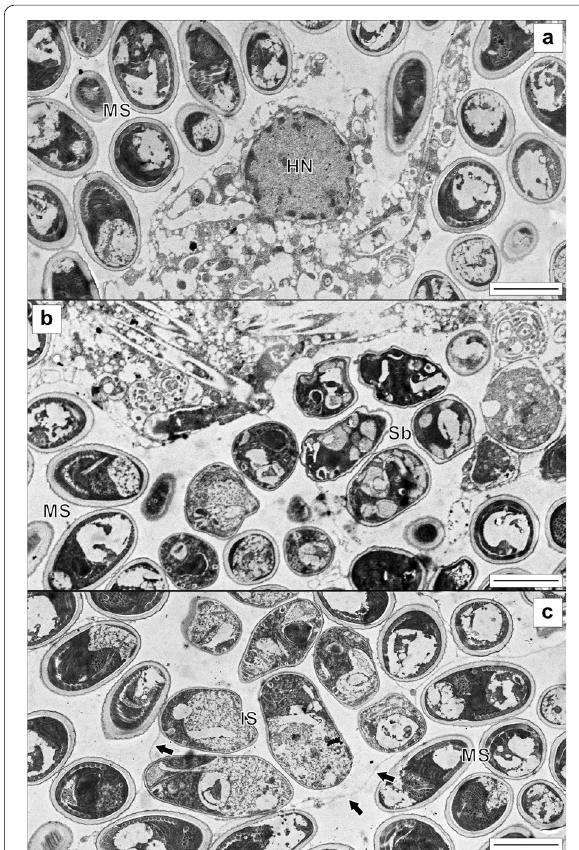
Fig. 3 Transmission electron micrographs of xenomas of Glugea thunni from the caecal mass of T hunnus thynnus from the Mediterranean Sea. a Mature spores and degenerative host cells. b and c Spores under development. MS—mature spores; IS— immature spores; Sb—Early sporoblast; HN, Host cell nucleus; black arrowhead—parasitophorous vacuole membrane (scale bars 2